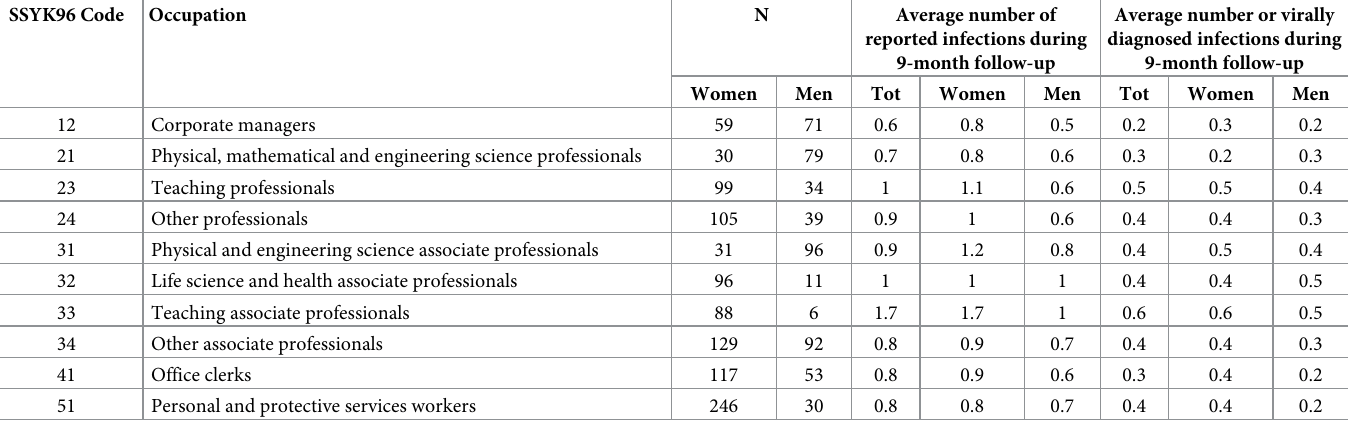
Table 3. Descriptive data on the number of women and men in the 10 largest occupational sub-major groups as well as the average amount of reported infections and virally diagnosed infections during the 9-month follow-up. SSYK96 Code